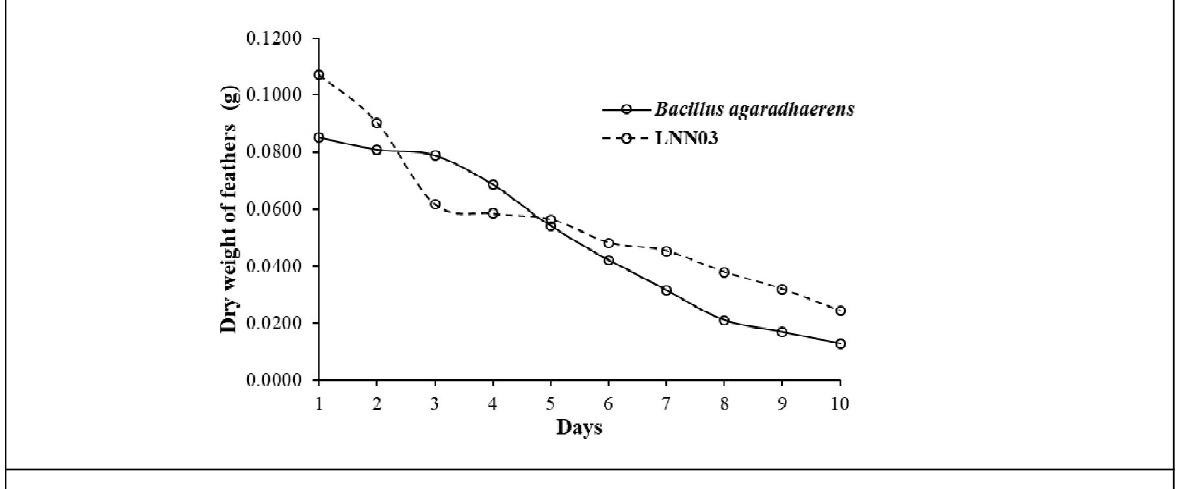
Figure 3: Profiles showing changes in dry weight of chicken feathers during the assay inoculated with isolates LNC06 and LNN03 from Lake Nakuru for 10 days The ash free dry weight of the feathers decreased with time during incubation. Bacillus agaradhaerens (LNC06) devoured the feathers from 0.022g to 0.0006g in 10 days. Despite both organisms degrading the feather substrate, LNN03 was